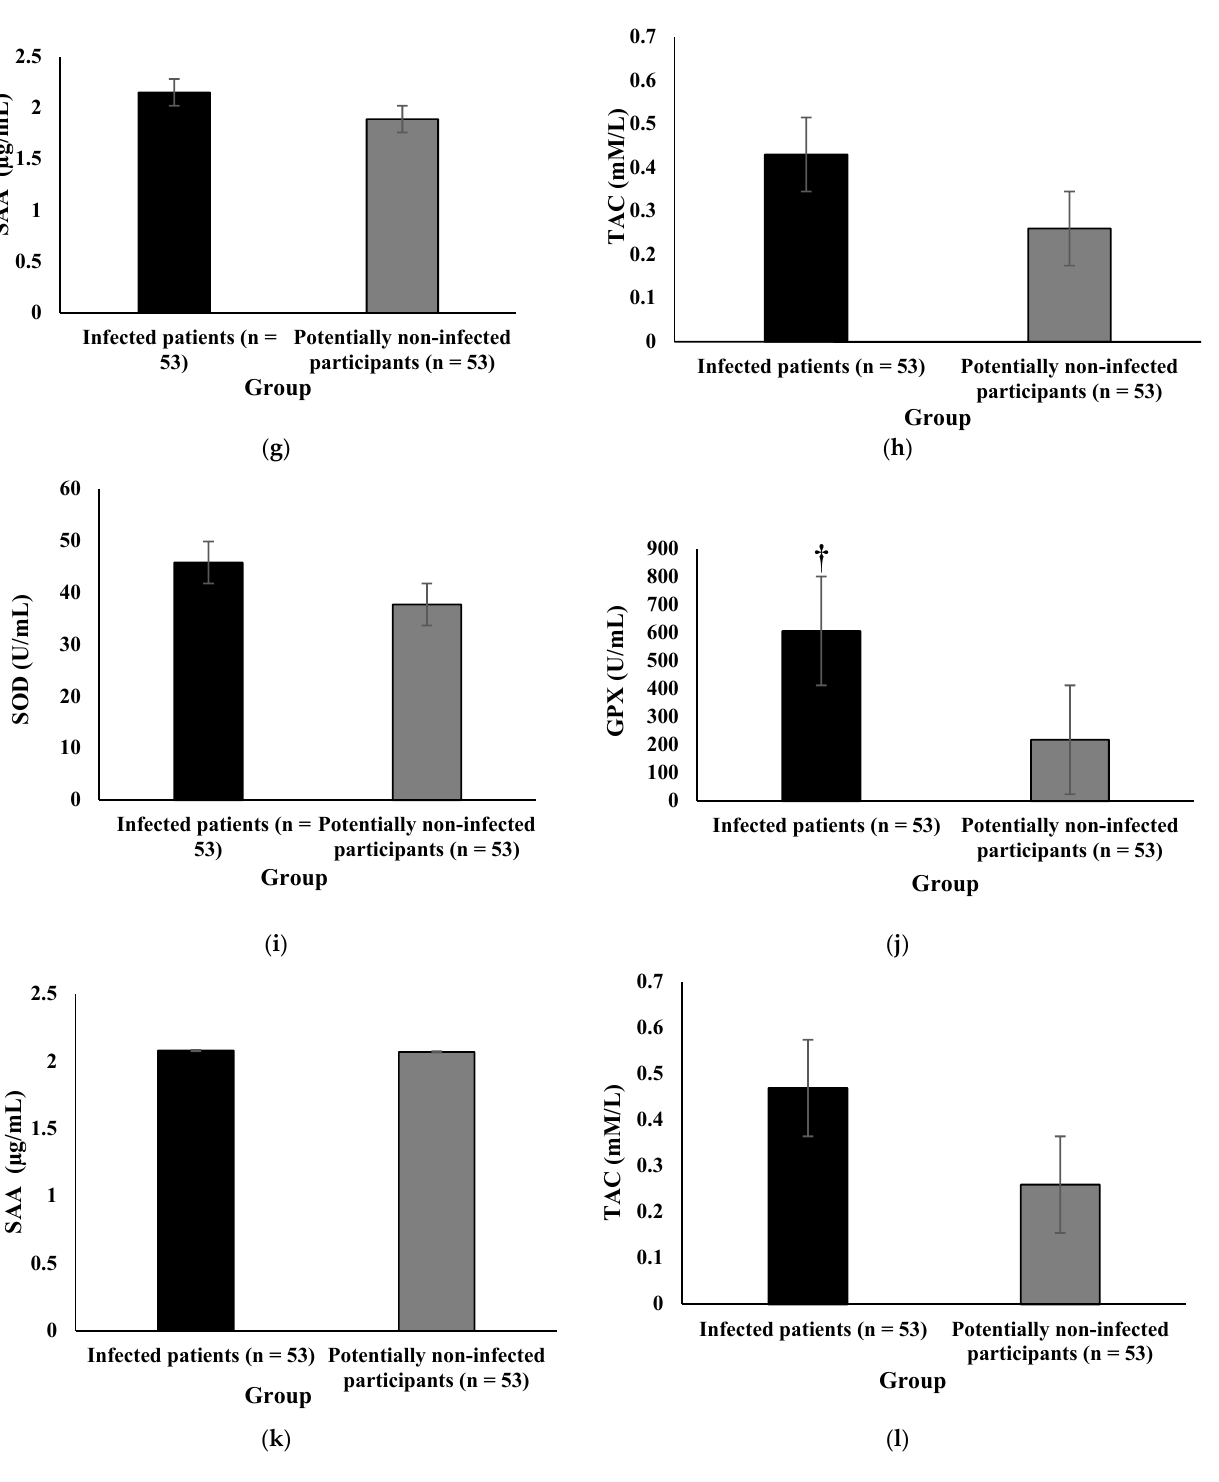
Figure 3. Comparison of SOD, GPx, SAA, and TAC serum concentrations in COVID-19 outpatients and controls after adjusting for the use of vitamin D supplements ( a – d ), all dietary supplements ( e – h ), and vitamin C supplements ( i – l ). An independent sample t -test was applied to analyze data. SOD ( a ), GPx ( b ), and TAC ( d ) concentrations were significantly higher among COVID-19 outpatients than in controls after adjusting for the use of vitamin D supplements. GPx was significantly higher among COVID-19 outpatients than in controls after adjusting for vitamin C ( j ) and all dietary supplements ( f ). GPx, glutathione peroxidase; SAA, serum amyloid A; SOD, superoxide dismutase; TAC, total antioxidant capacity. * p = 0.003, ** p = 0.022, *** p = 0.028, δ p = 0.005, and † p =